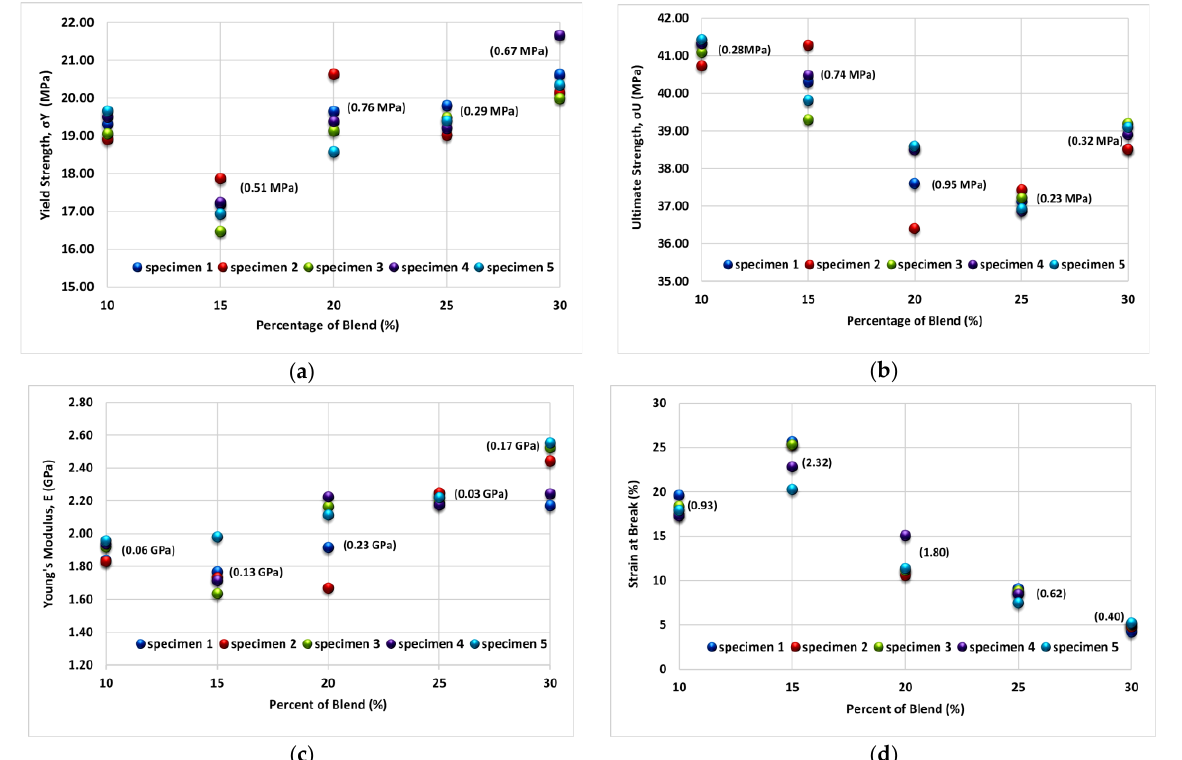
Figure 3. Distribution of mechanical properties determined for each tested specimen for a specified percentage of DE in the blend: ( a ) yielding strength; ( b ) ultimate strength; ( c ) Young’s modulus; and ( d ) strain at break.